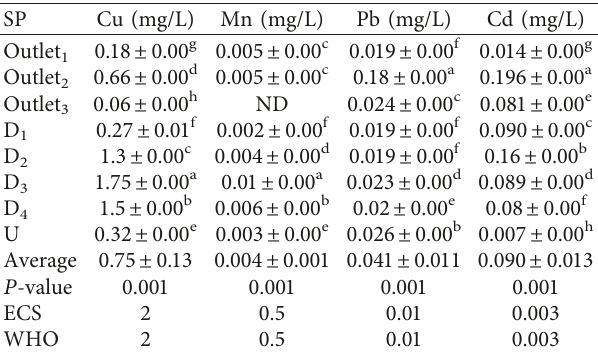
Table 4: The studied heavy metal content of the analyzed waste- water samples.